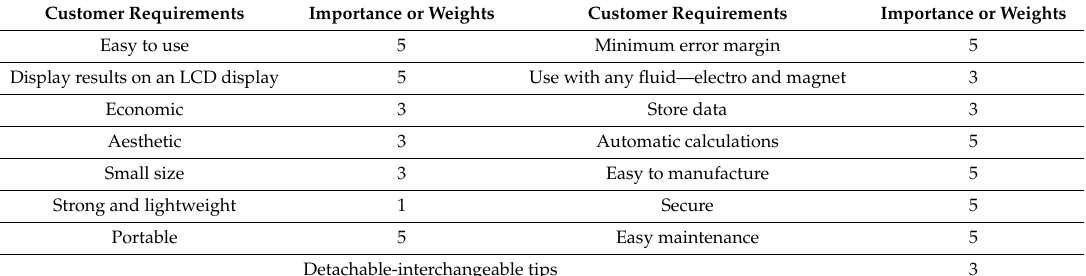
Table 4. Customer requirements and their